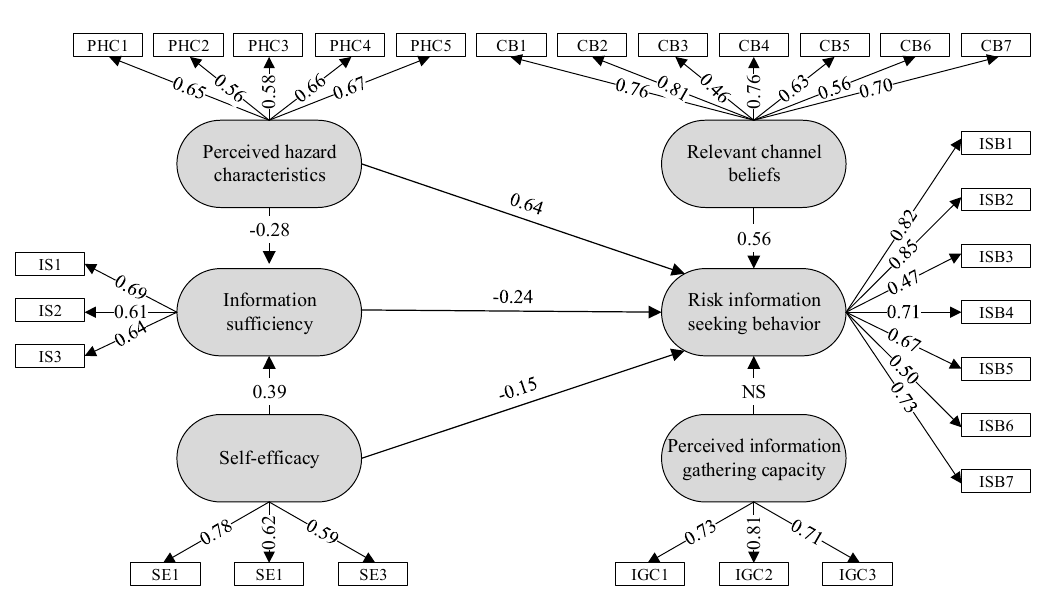
Figure 4. Path coefficients of the structural equation model (SEM). Figure 4. Path coe ffi cients of the structural equation model